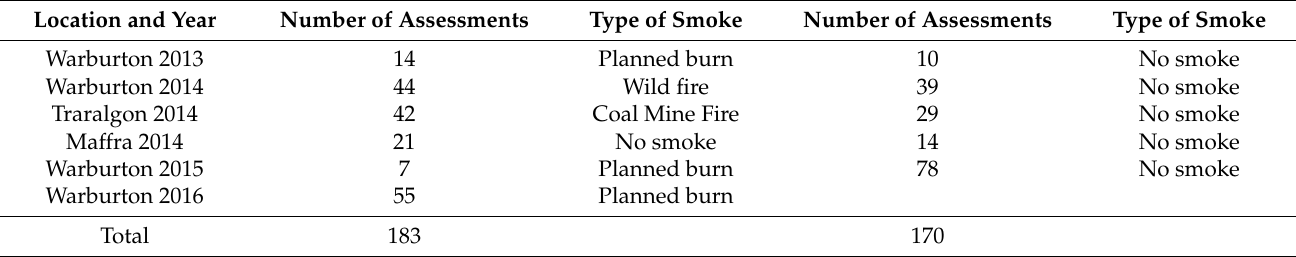
Table 1. Number of assessments conducted per year and exposure type. Note that no clean air assessments were conducted in 2016. Assessments were carried out on those participants who were tested in Warburton in 2015 when there was no